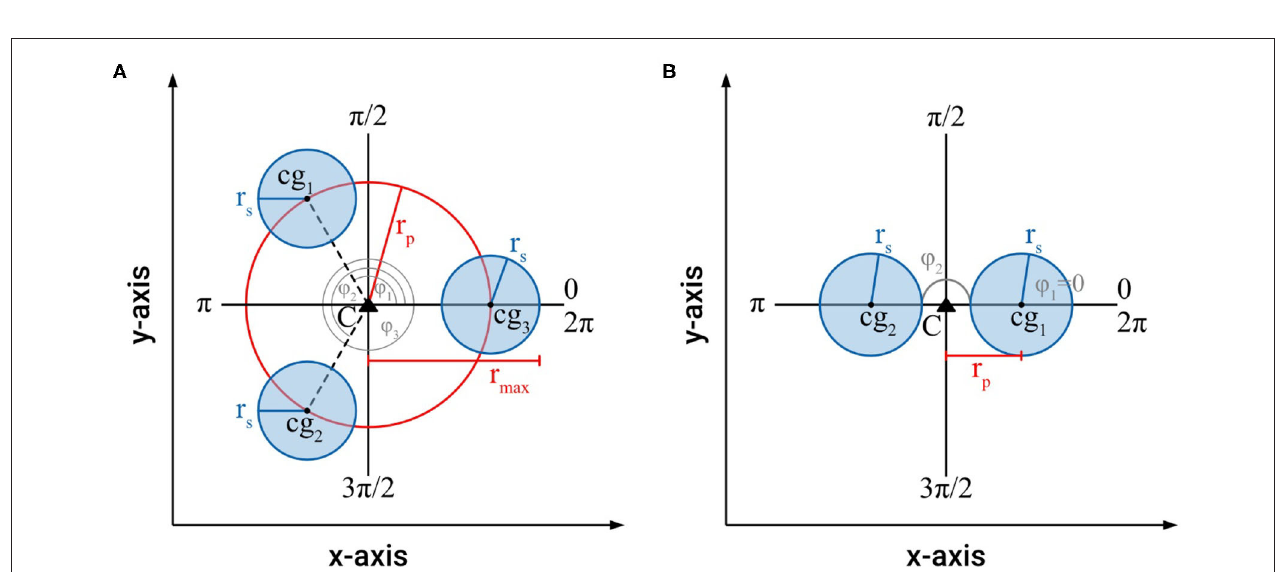
FIGURE 6 | (A) Schematic of the cross-section of an intertwined, braided structure with a 3-fold symmetry ( n = 3), which fulfills the boundary conditions (1)–(5), showing the parameters used to calculate cross-sectional area and axial second moment of area. (B) Schematic of the cross-section of an intertwined, braided structure with a 2-fold symmetry ( n = 2), which fulfills the boundary conditions (1)–(5), showing the parameters used to calculate cross-sectional area and axial second moment of area.